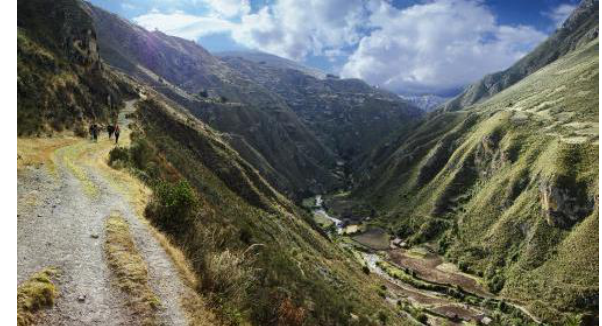
Figure 2. Tramo Huanuco Pampa - Huamachuco, Path trace in the valley of the river Taparaco, Llata, Huamalíes, Huánuco. Qhapaq Ñan